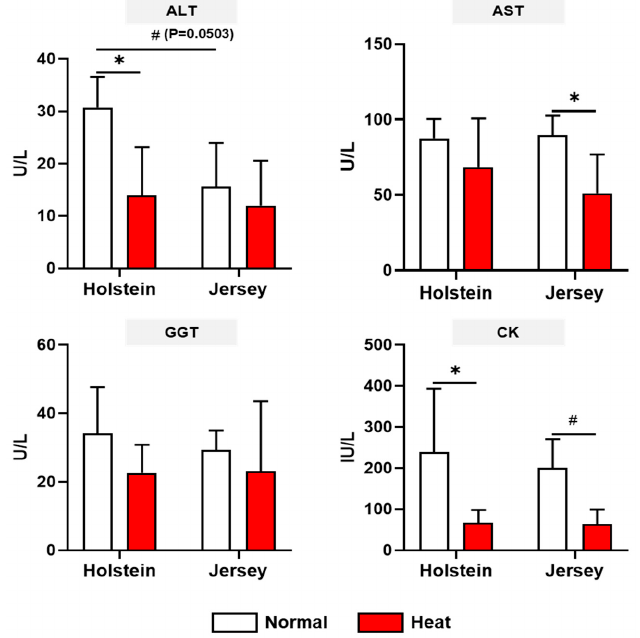
Figure 4. Changes in serum enzyme concentrations from two breeds of dairy cow under heat stress. Biochemistry analysis of Holstein and Jersey cows was conducted for serum enzymes un- der normal and high-heat conditions. Data are represented as means ± standard deviation (SD); n = 7–8 animals/group. Values were statistically analyzed by a mixed-effects model with Tukey’s multiple comparison test. * p < 0.05 and # p < 0.1; ALT, alanine aminotransferase; AST, aspartate aminotransferase; GGT, gamma-glutamyltransferase; CK, creatine kinase.